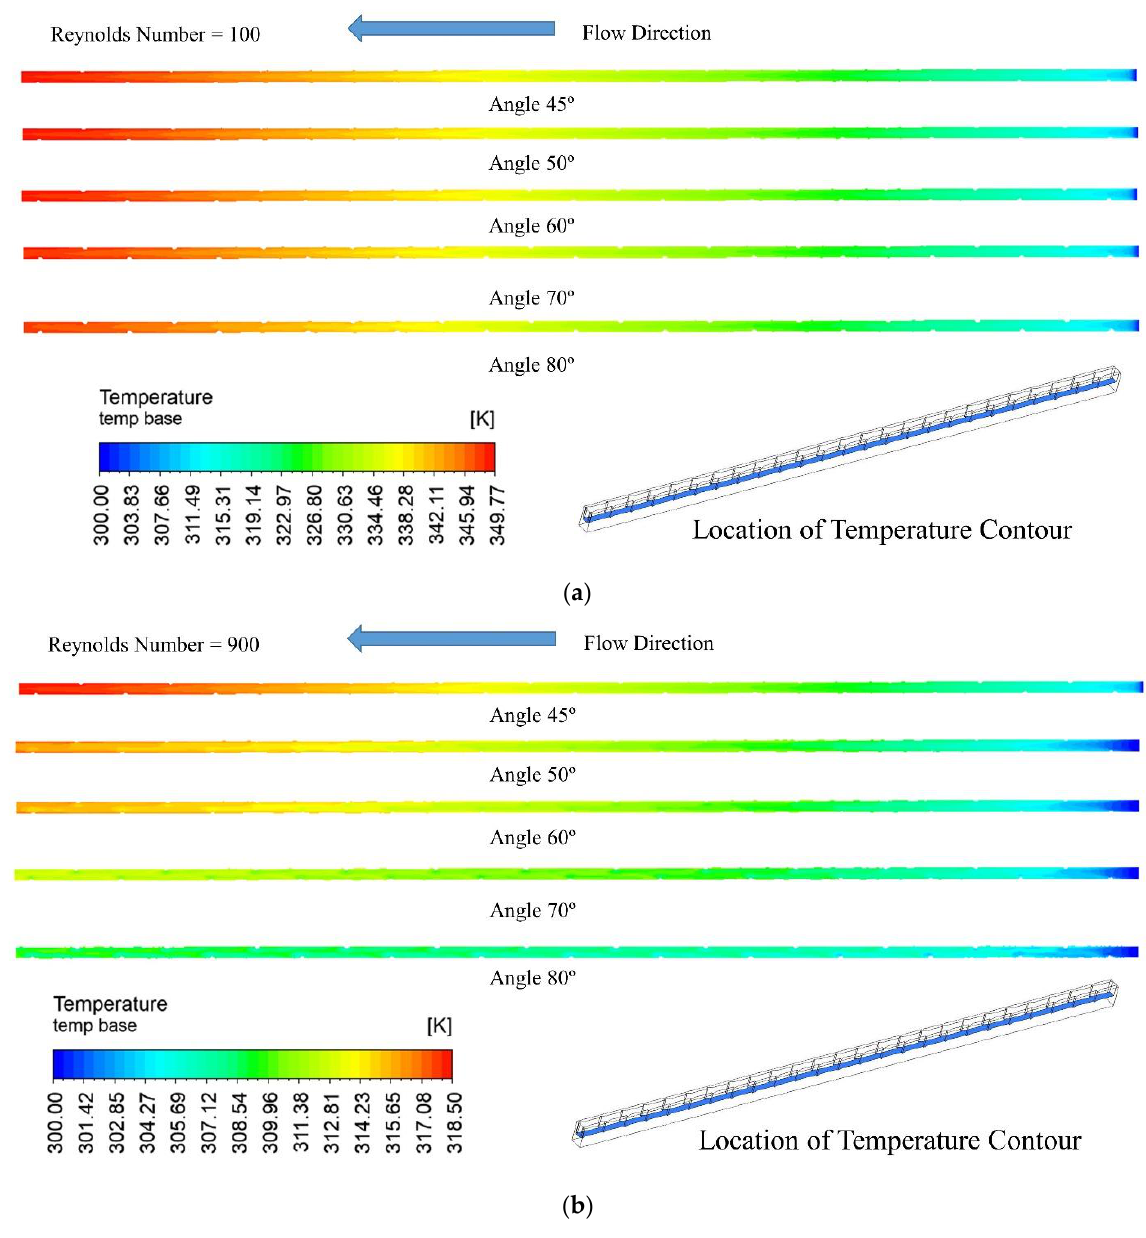
Figure 8. Variation of temperature at the base of the interface between fluid and MCHS at ( a ) Re = 100 and ( b ) Re = 900 .